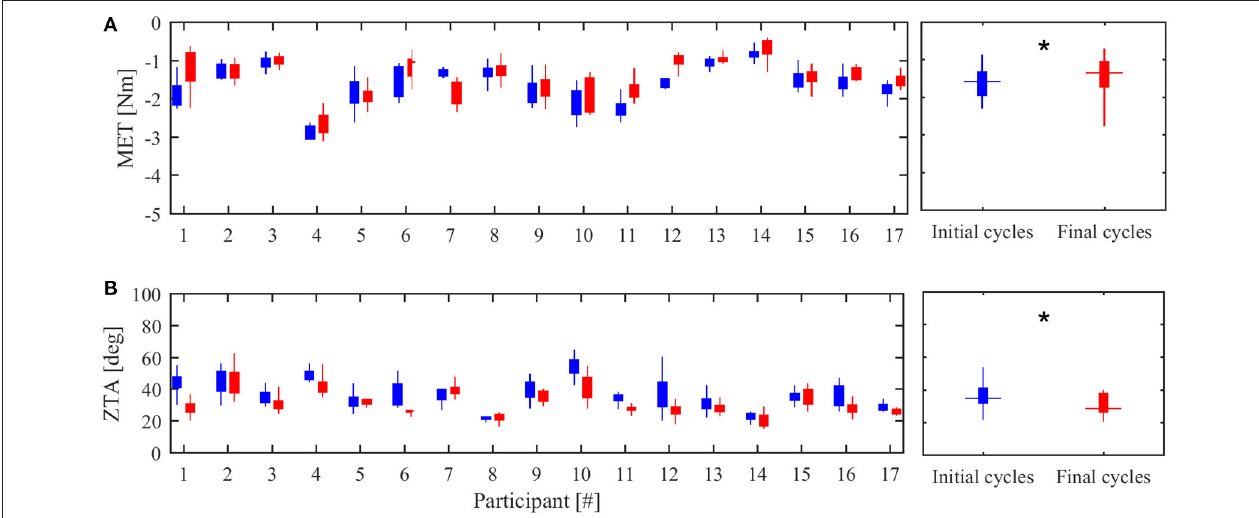
FIGURE 5 | Intra-day therapy effectiveness. (A) Maximum extension torque ( MET ) in the initial (blue) and final (red) cycles of treatment. (B) Zero-Torque Angle ( ZTA ) in the initial (blue) and final (red) cycles of treatment. The left panels show the median values and 90% confidence interval for each subject. The right panel reports the inter-subject median value and confidence interval. *indicates statistical significant difference ( p <